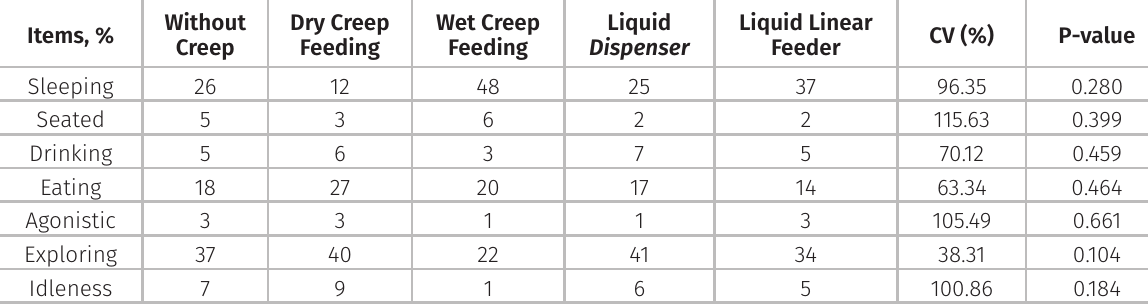
Table VI. Behavior of piglets (%) after weaning and transfer to the nursery on day 2. Items,